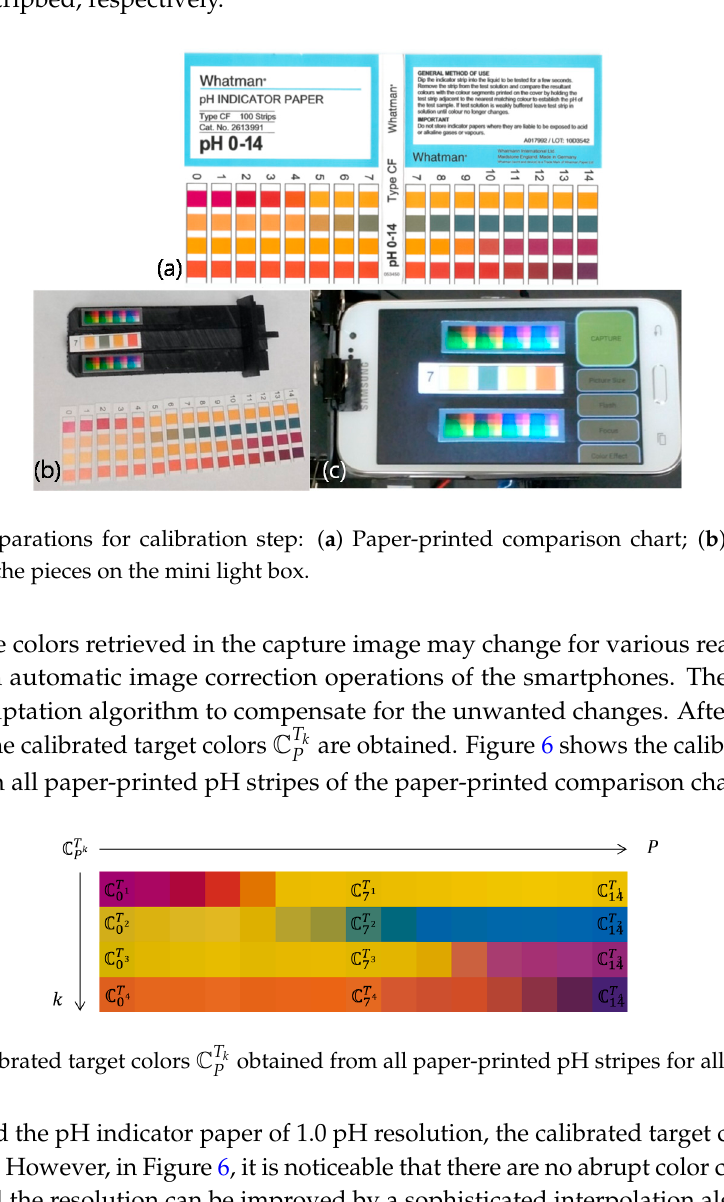
Figure 7. High-resolution calibrated target colors (cid:2435) (cid:3043)(cid:3021) (cid:3286) interpolated from ℂ (cid:3017)(cid:3021) (cid:3286) . Figure 8 shows the u’v’ color component of (cid:2435) (cid:3043)(cid:3021) (cid:3286) corresponding to Figure 7. The curves of the 4 color patches are non-linear; therefore, finding the best match of (cid:2424) (cid:3021) (cid:3286) among (cid:2435) (cid:3043) (cid:3021) (cid:3286) can be a good